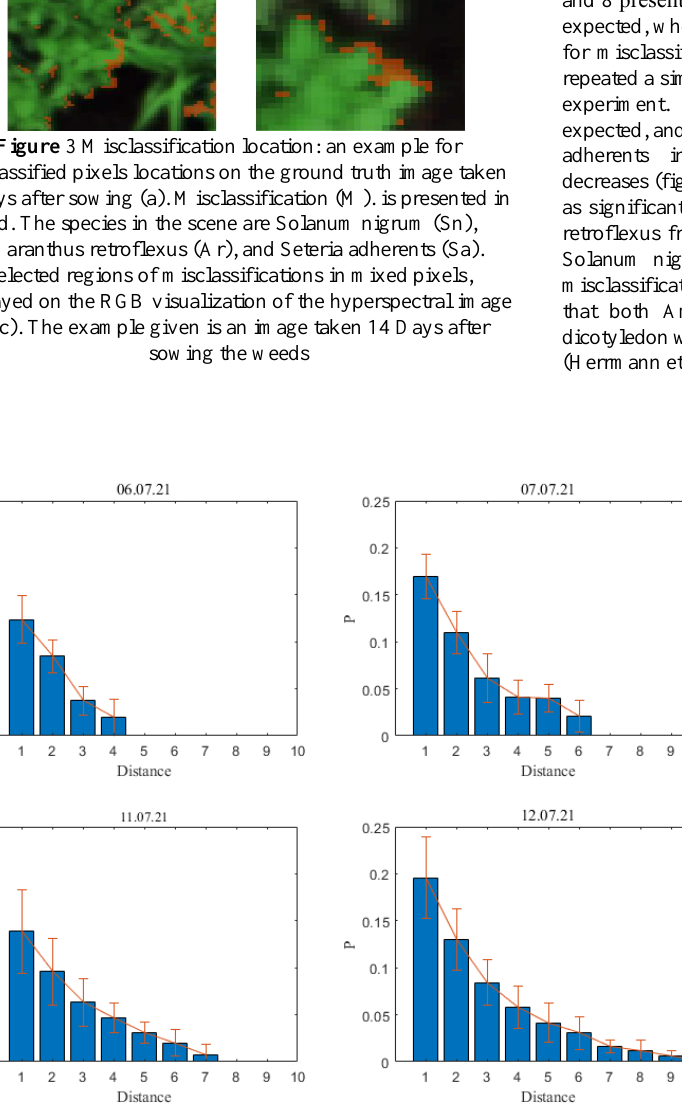
This contribution has been peer-reviewed. The double-blind peer-review was conducted on the basis of the full paper. https://doi.org/10.5194/isprs-annals-V-3-2022-477-2022 | © Author(s) 2022. CC BY 4.0